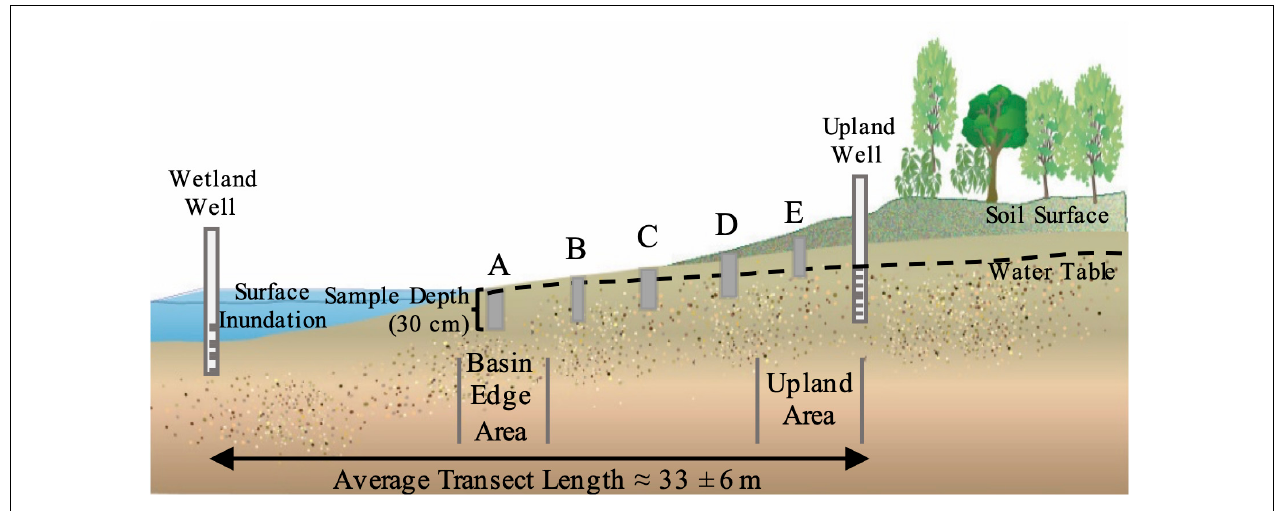
FIGURE 1 | Approximate location and depth of groundwater well installation, as well as the approximate location of the five hydrologic zones (A–E) along the topographic